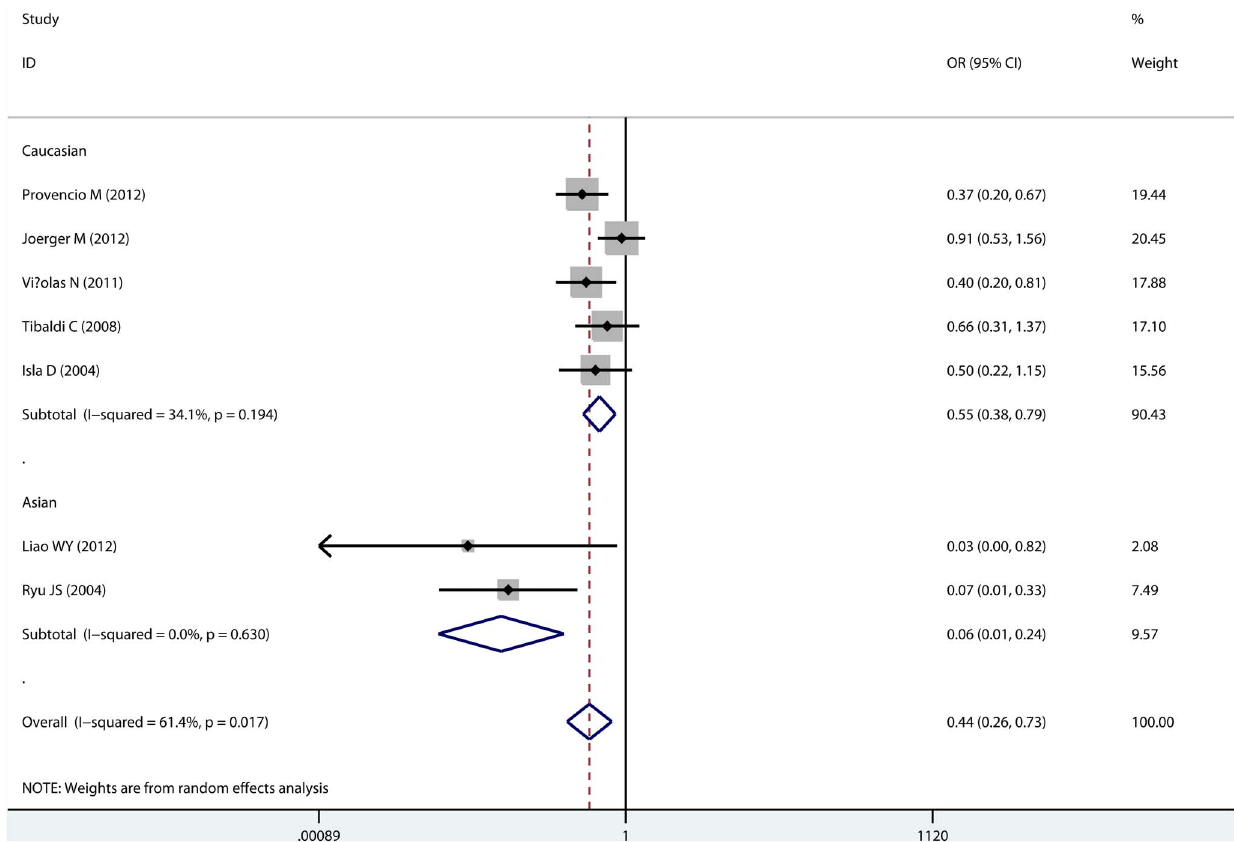
Figure 2. Association of XPD Asp312Asn polymorphism with response to platinum-based chemotherapy. This forest was estimated with allele comparison (Asn vs. Asp).